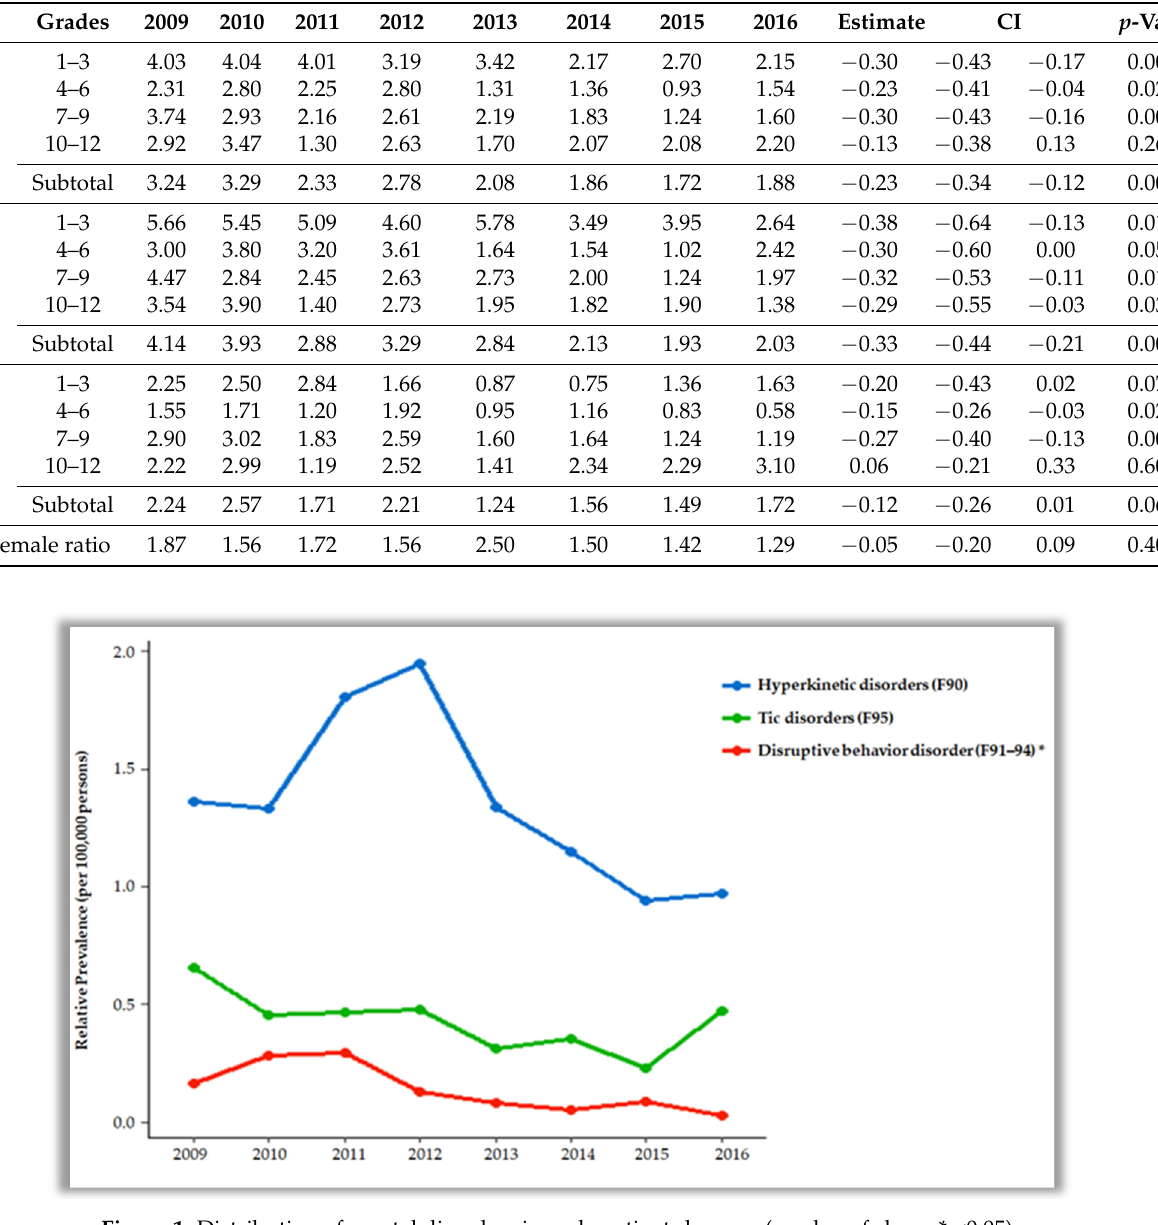
Figure 2. Distribution of mental disorders in female patients by year ( p value of slope, * <0.05). Of the 1,467 participants, 645 (45.0%) (423 males and 222 females) dropped out early from the outpatient clinic (Table S3). Factors predicting continuity of follow-up were pa- tients who were female, in grades 7–12, with mental disorders, including depressive dis- order (F32, 33), hyperkinetic disorders (F90), and tic disorders (F95), and with one or more clinical diagnosis (Table 2). Table 2. Factor analysis for the treatment continuity defined as more than three outpatient visits. Item